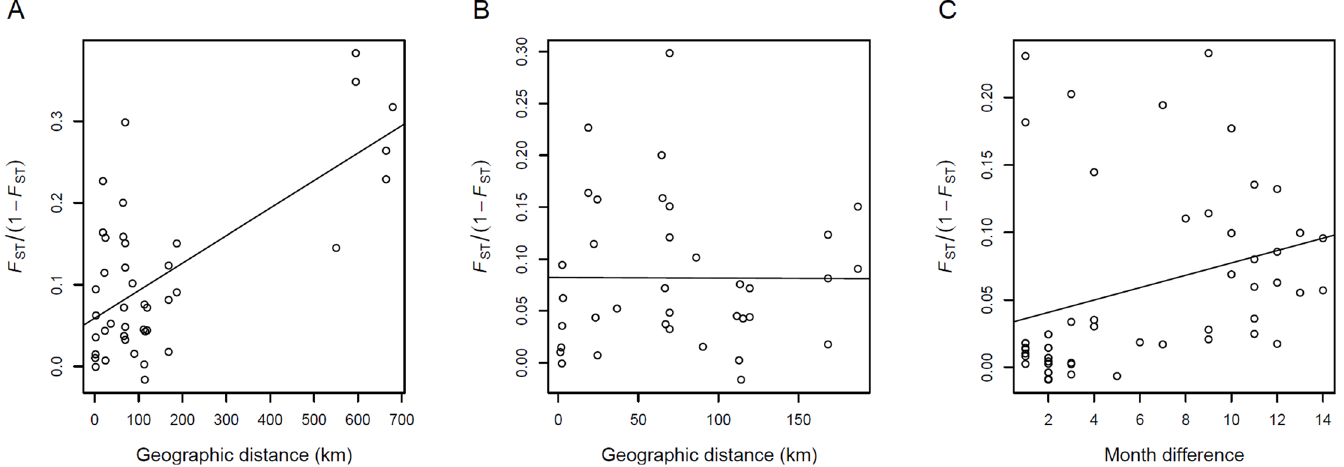
Fig 5. F ST of potato psyllid populations separated spatiotemporally. (A) Regressionof F ST versus degreeof geographic separationbetweenpairs of psyllidpopulationsdiffering in distance(but collectedduringthe same month) for all populationpairs across samplingdates from August, 2012 through October, 2013, and (B) for the same pairs of populationswithout the Twin Fall, ID, outgroup. (C) Regressionof F ST values for pairwisepopulationsonly differing in time (but collectedat the same locations) across months.